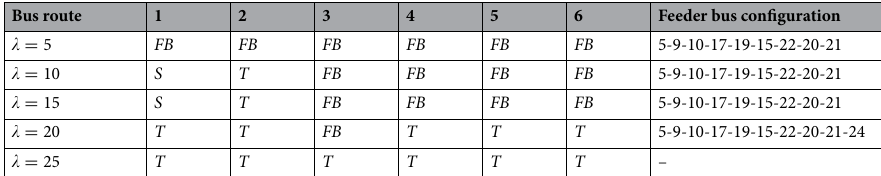
Table 8. Adjustment schemes with different passengers’ values of time. Adjustment schemes S , T , and FB represent the stop-skipping strategy, the truncation strategy, and the feeder bus service should be implemented,